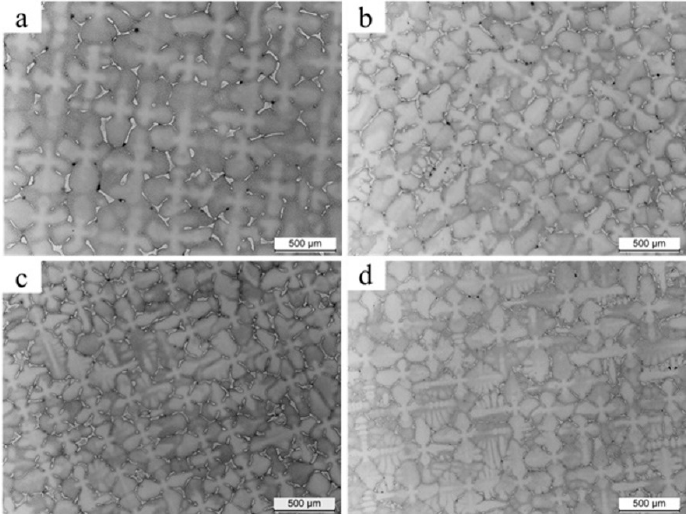
Figure 2. Dendritic microstructure (LM) of CMSX-4 superalloy solidified at different withdrawal rate: ( a ) 1, ( b ) 3, ( c ) 5 and ( d ) 7 mm/min.